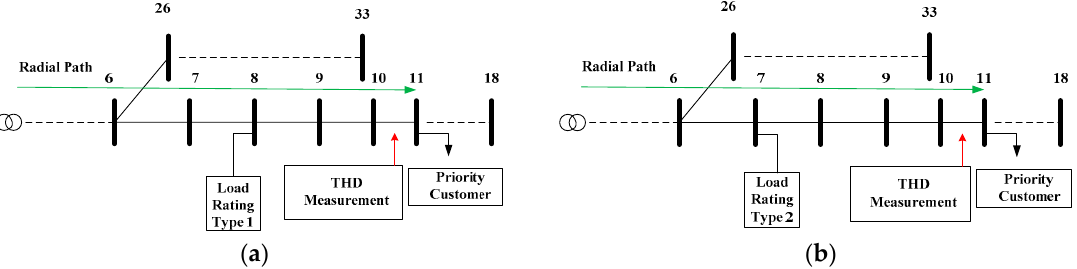
Figure 3. ( a ) Non-linear load connected at bus 8; ( b ) A 200kW resistive load is connected at bus number 7. THD: Total Harmonic Distortion.